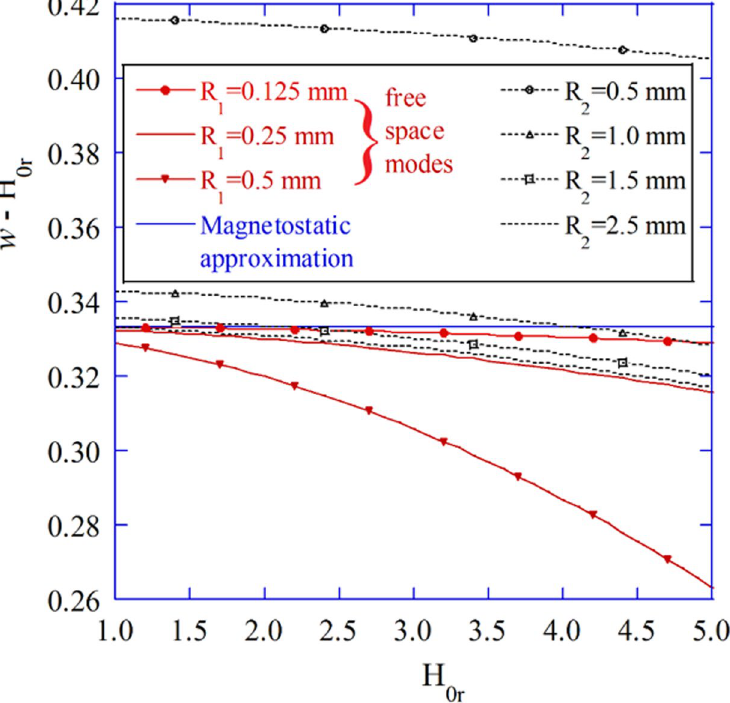
Figure 4. MPR frequency variation. Variation of the MPR frequency with the radius of the sample ( R 1 ) and the radius of the perfectly conducting spherical enclosure ( R 2 ) as computed with the TDE. Influence of the conducting enclosure (curves in black color) is shown only for R 1 = 0.25 mm.